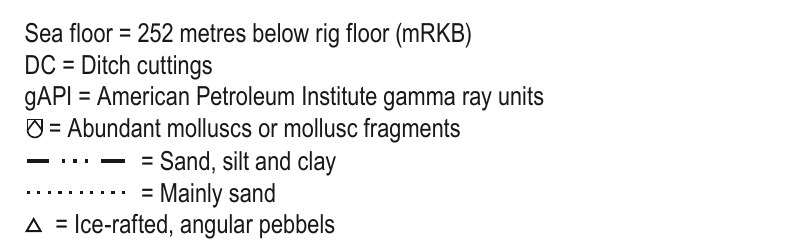
Figure 53. Well summary figure including gamma-ray log, lithology, lithostratigraphic units, sub-series, stage, paleobathymetry and analysed samples for the upper part of the investigated sequence in well 30/5–2 (middle Miocene to mainly Gelasian) including the well reference section for the Eir Formation (upper part; modified after Eidvin et al.,